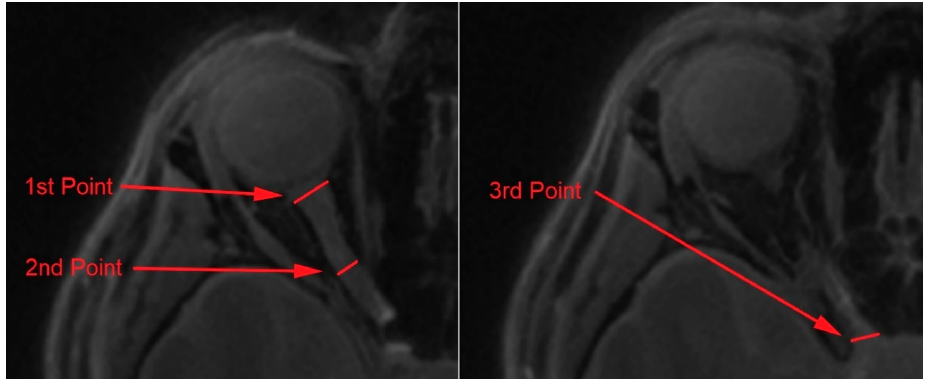
Figure 3. Measurement of the optic nerve dimensions at three selected points: (1) 1st point of interest, (2) 2nd point of interest, (3) 3rd point of